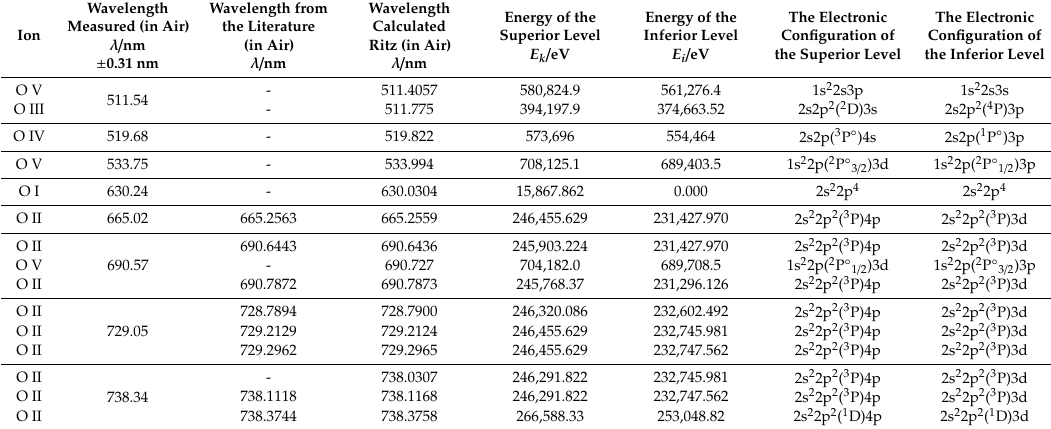
Table 4. Atomic oxygen fluorescence (BPA in acetone solution with c =